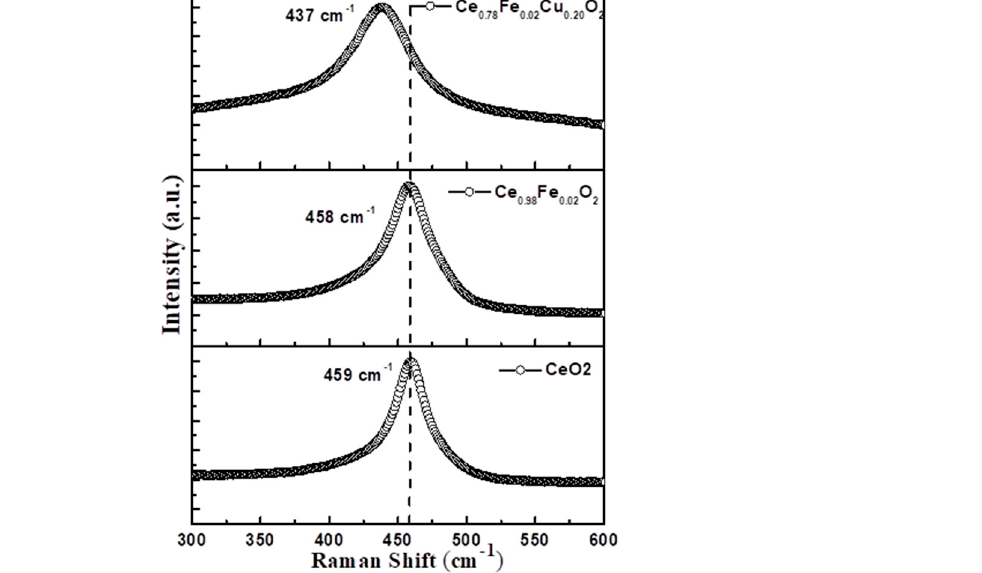
Figure 4. Raman spectra of pure CeO 2 , Ce 0.98 Fe 0.02 O 2 , and Ce 0.78 Fe 0.02 Cu 0.20 O 2 nanoparticles.